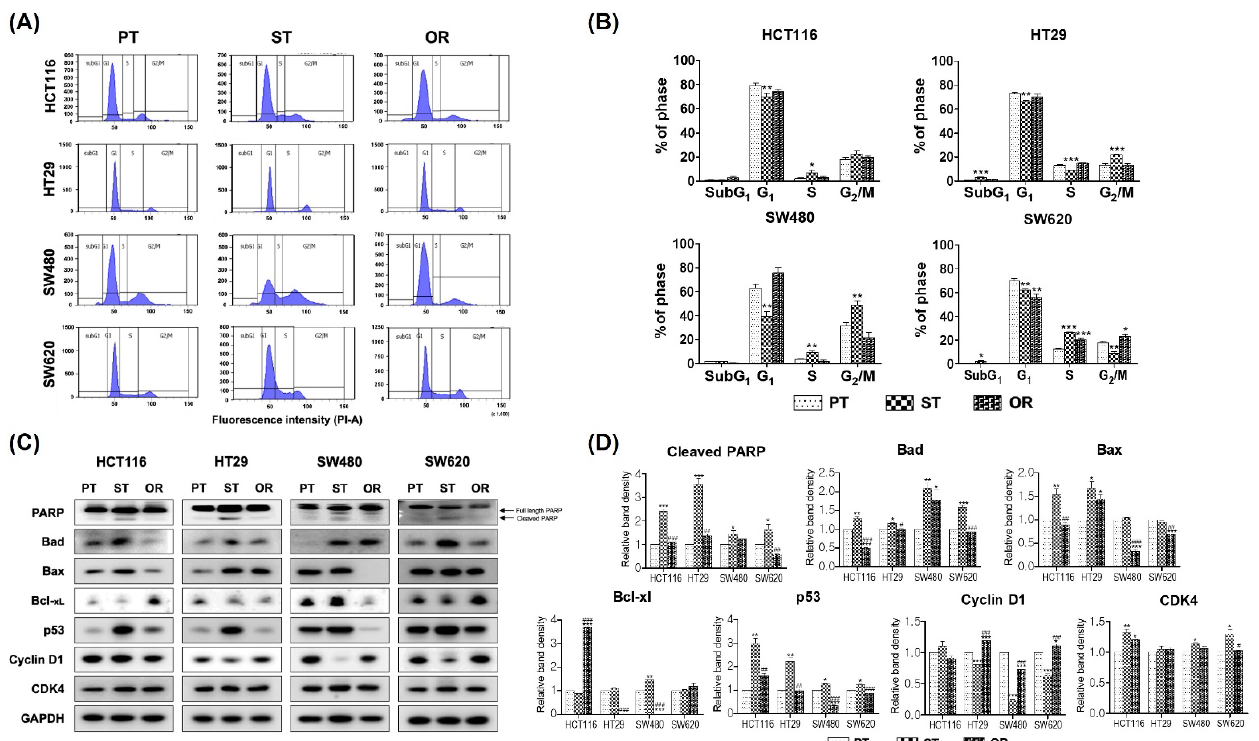
Figure 3. Effects of oxaliplatin resistance on the cell cycle progression and induction of apoptosis in the parental (PT), 2.5 µM oxaliplatin single treated PT for 24 h (ST) and oxaliplatin-resistant (OR) colorectal cancer (CRC) cells of HCT116, HT29, SW480 and SW620. ( A ) Cellular DNA was analyzed by flow cytometry. ( B ) The percentage of cells in each phase was calculated from each histogram. ( C ) Protein expression involved in apoptosis and cell cycle progression was analyzed by immunoblot analysis. ( D ) Graphical analysis of band intensities normalized for protein loading with GAPDH. Columns and error bars represent means ± standards deviation of immunoblot band intensities of 3 separate protein preparations. The * statistics showed the comparison with PT and the # statistics showed the comparison between ST and OR. * or # , p < 0.05; ** or ## , p < 0.01; *** or ### , p < 0.001. GAPDH, glyceraldehyde 3-phosphate dehydrogenase.